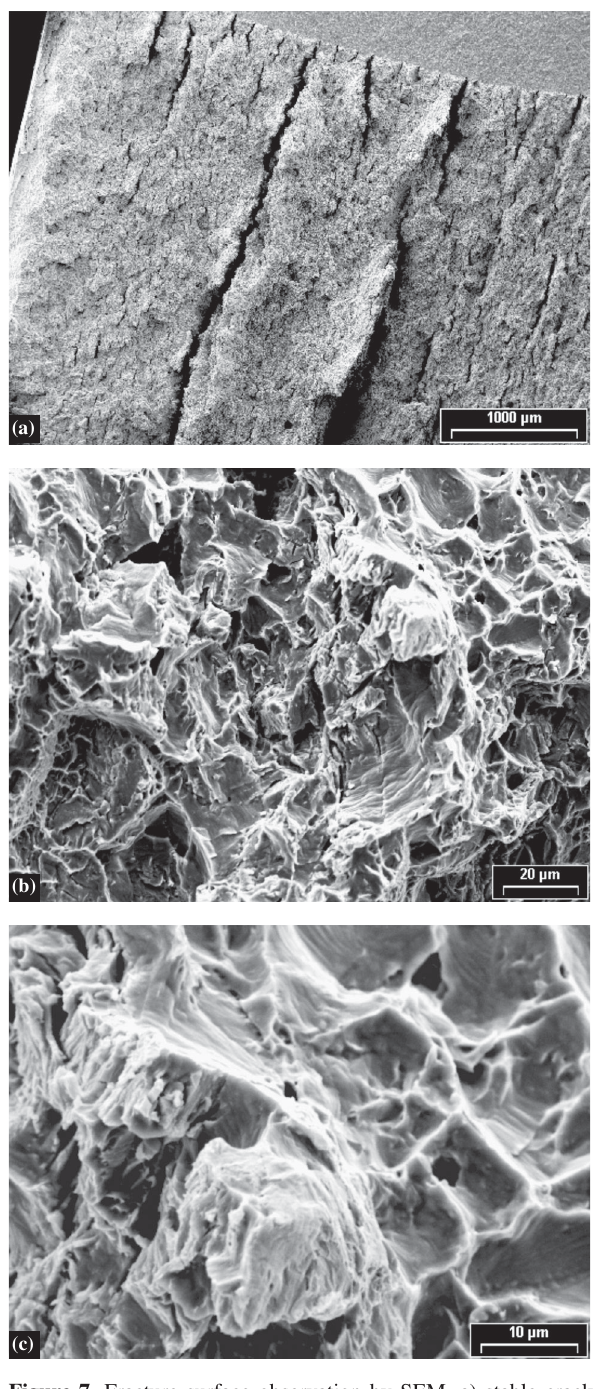
Figure 7. Fracture surface observation by SEM, a) stable crack growth and longitudinal cracks, b) beginning of stable crack growth, c) zoom of